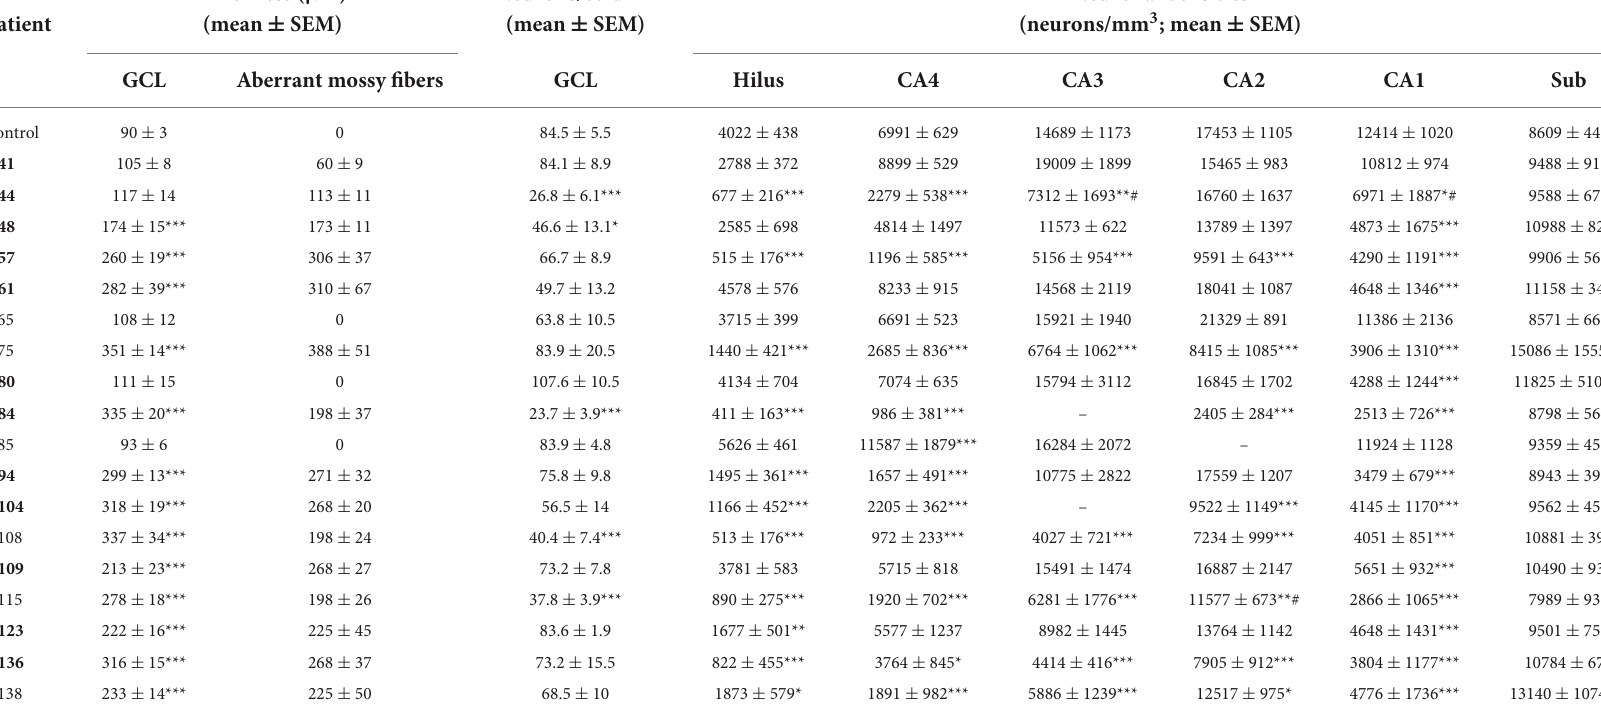
TABLE 4 Quantitative analysis of hippocampal histological alterations in a group of epileptic patients that underwent TLE surgery compared to normal hippocampi obtained by autopsy. Neurons/column Neuronal